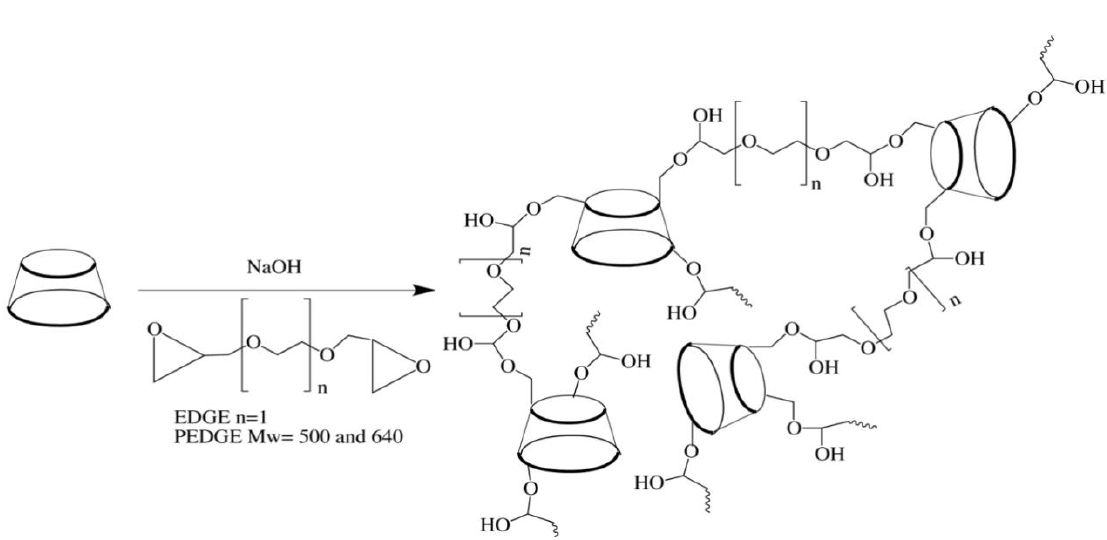
Table 1. Experimental conditions for polymer synthesis.